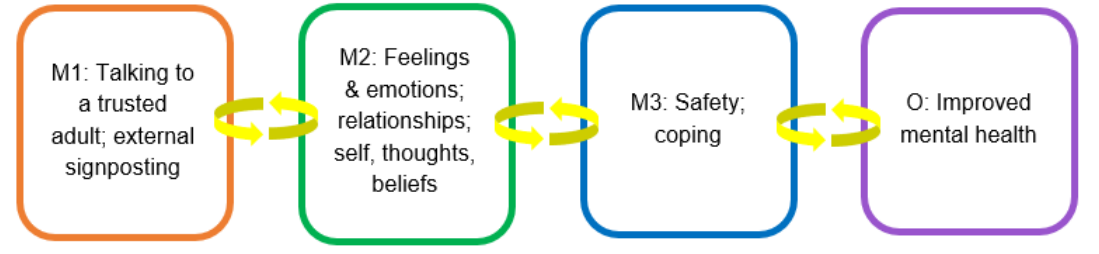
Figure 3. Interventions for talking and support.